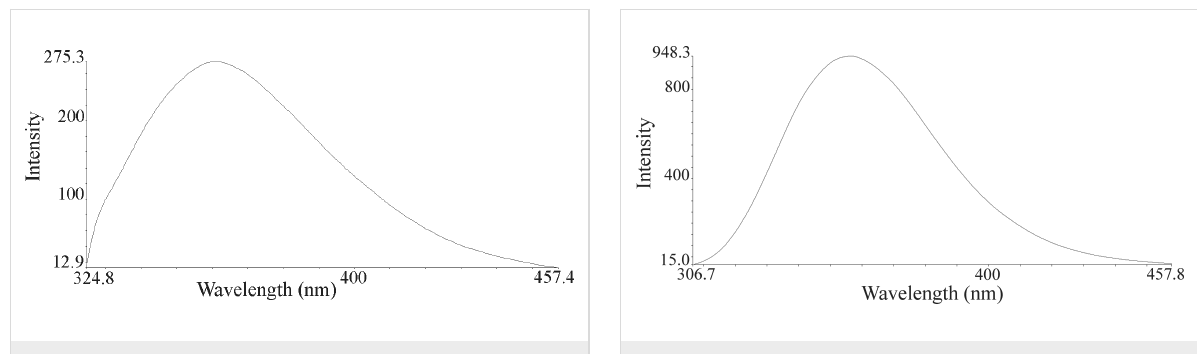
Figure 12: Fluorescence spectrum of compound 6 in